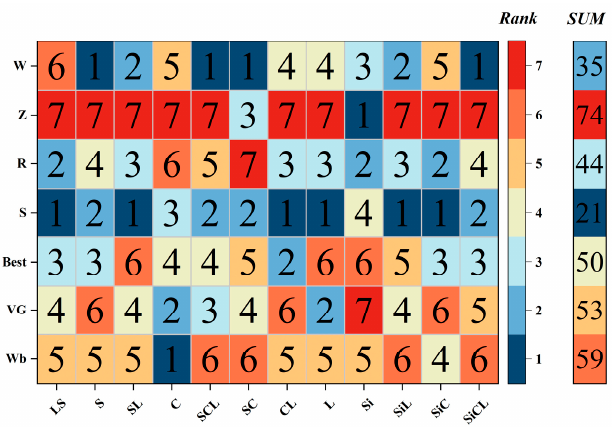
Figure 4. Comprehensive rank scores for the simulated soil non-sample points based on coefficient of determination ( R 2 ), root-mean-square error ( RMSE ), mean absolute error ( MAE ) and corrected Akaike’s information criterion ( AICc ) for different texture classes of soil. Each scheme is ranked from 1 (best) to 7 (worst).